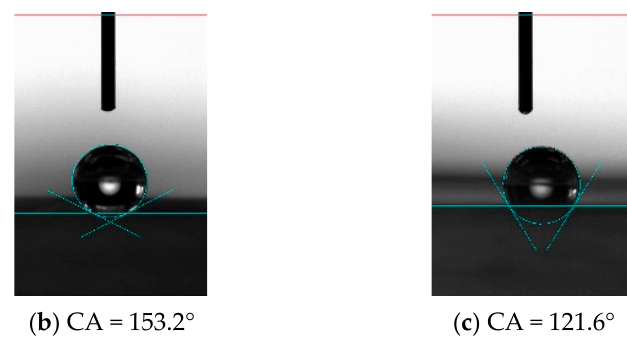
Figure 18. Hydrophobic characteristics of microstructures with different tilt angles when the mi- crostructure width is 30 μ m. ( a ) 90°; ( b ) 45°; ( c ) 30°.